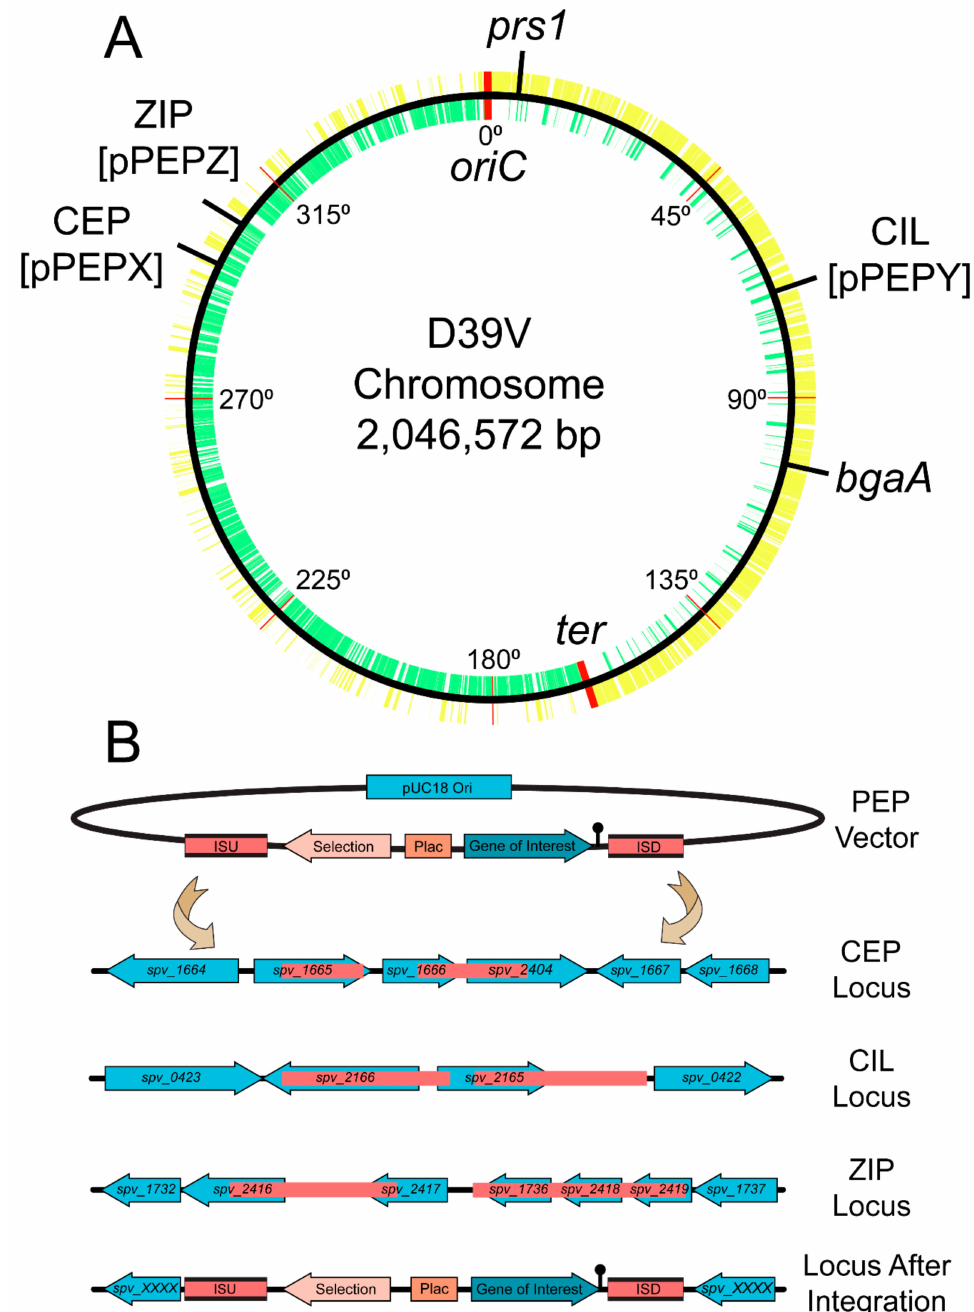
Figure 2. Chromosomal location of integration loci and integration schematic. ( A ) D39V chromosome with all positive strand genes (yellow), negative strand genes (green), and labeled integration loci. Position around the chromosome is demarcated every 45 degrees and origin of replication and terminus are indicated in red. Note that strain D39V has a large inversion around the ter region compared to laboratory strain R6 [14]. ( B ) Representation of insertion sequence upstream (ISU) and insertion sequence downstream (ISD) in pink for available PEP vectors. Double crossover event leads to stable integration in CEP (chromosomal expression platform, pPEPX), CIL (chromosomal integration locus, pPEPY), or ZIP (PEPZ Integration Position, pPEPZ) locus at indicated chromosomal locations based on most recent D39V genome